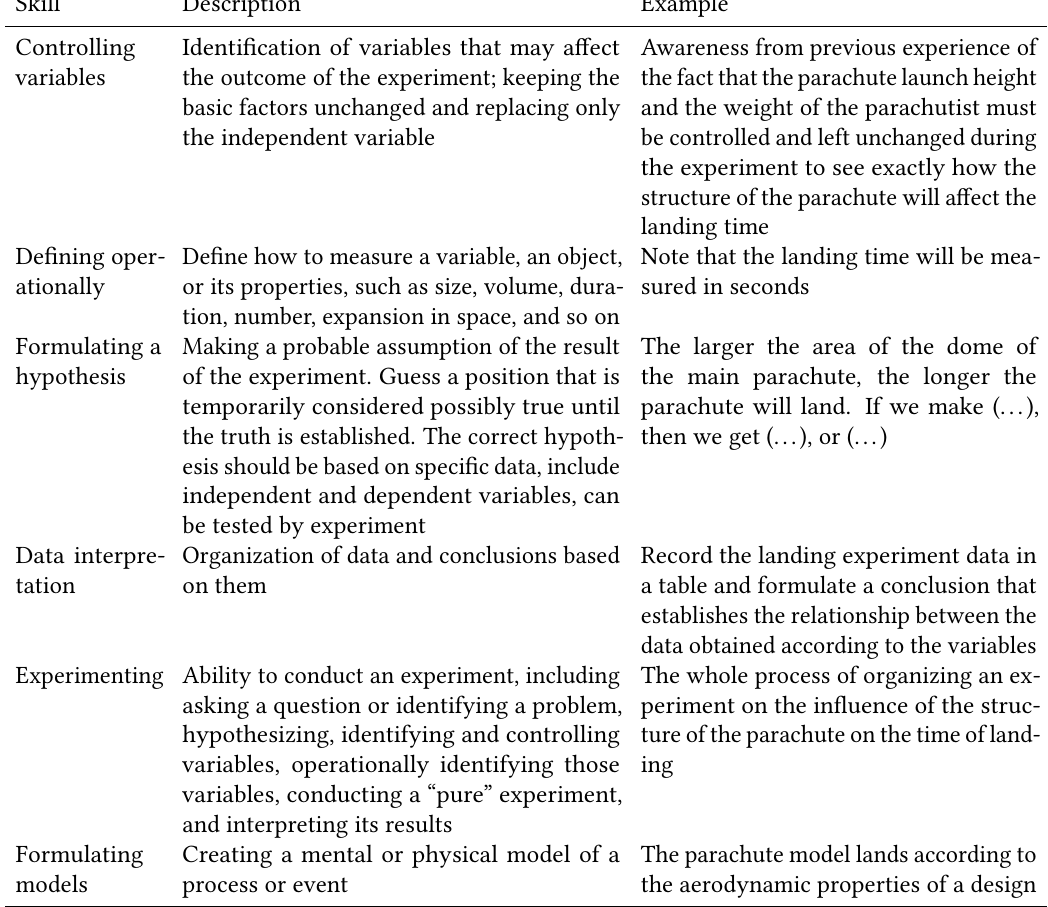
Table 3 Integrated skills in organization of scientific processes.